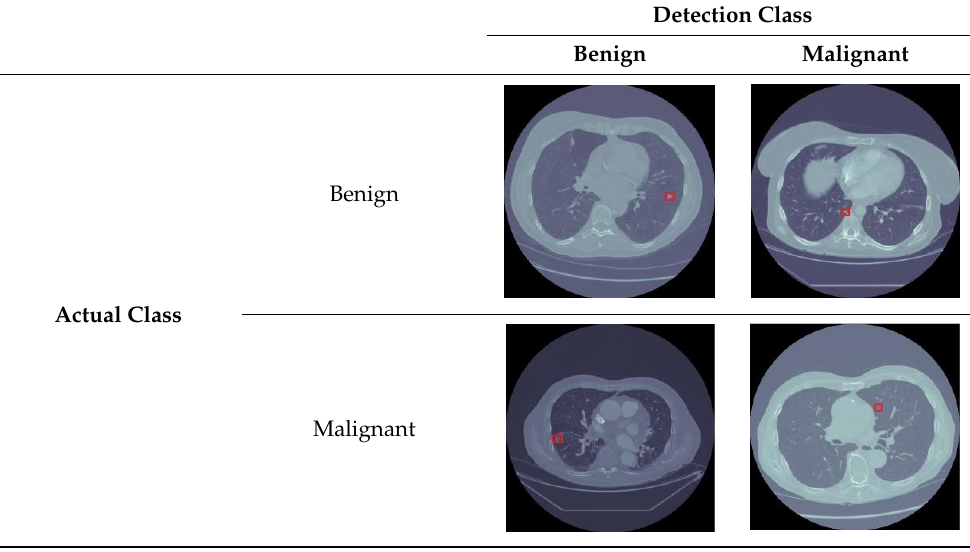
Table 12. Detection results of AlexNet with the SGD optimizer on the LUNA16 dataset.